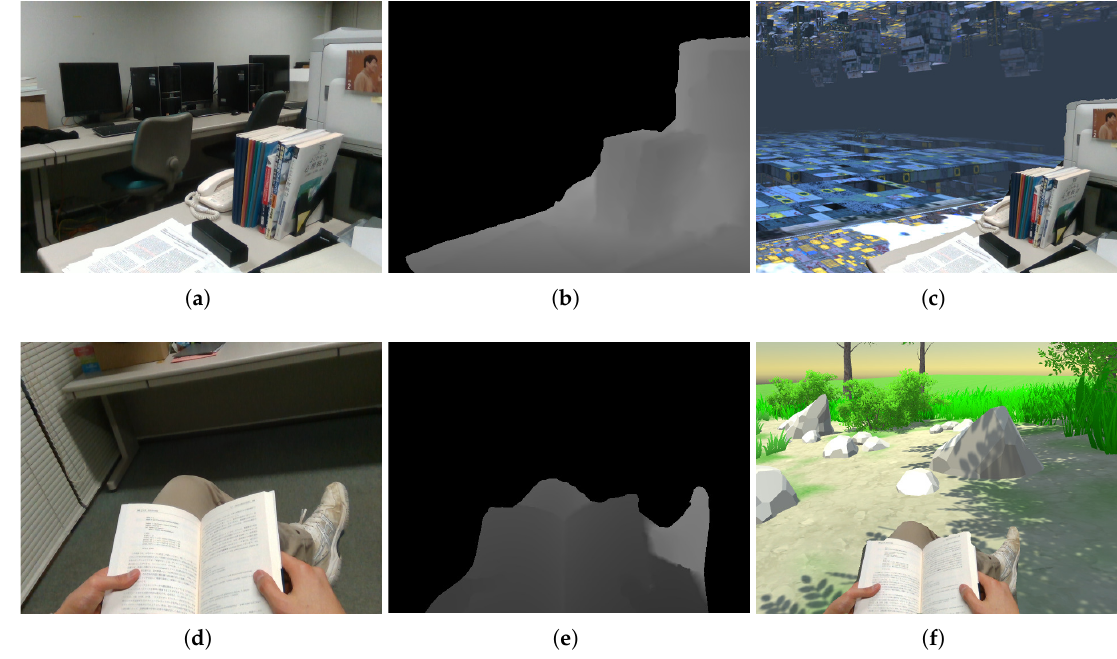
Figure 13. Two application examples: ( a – c ) a workspace and ( d – f ) reading in a small space. ( a , d ) Real-world images. ( b , e ) Depth images inpainted using the proposed method. ( c , f ) Composite results placed in virtual